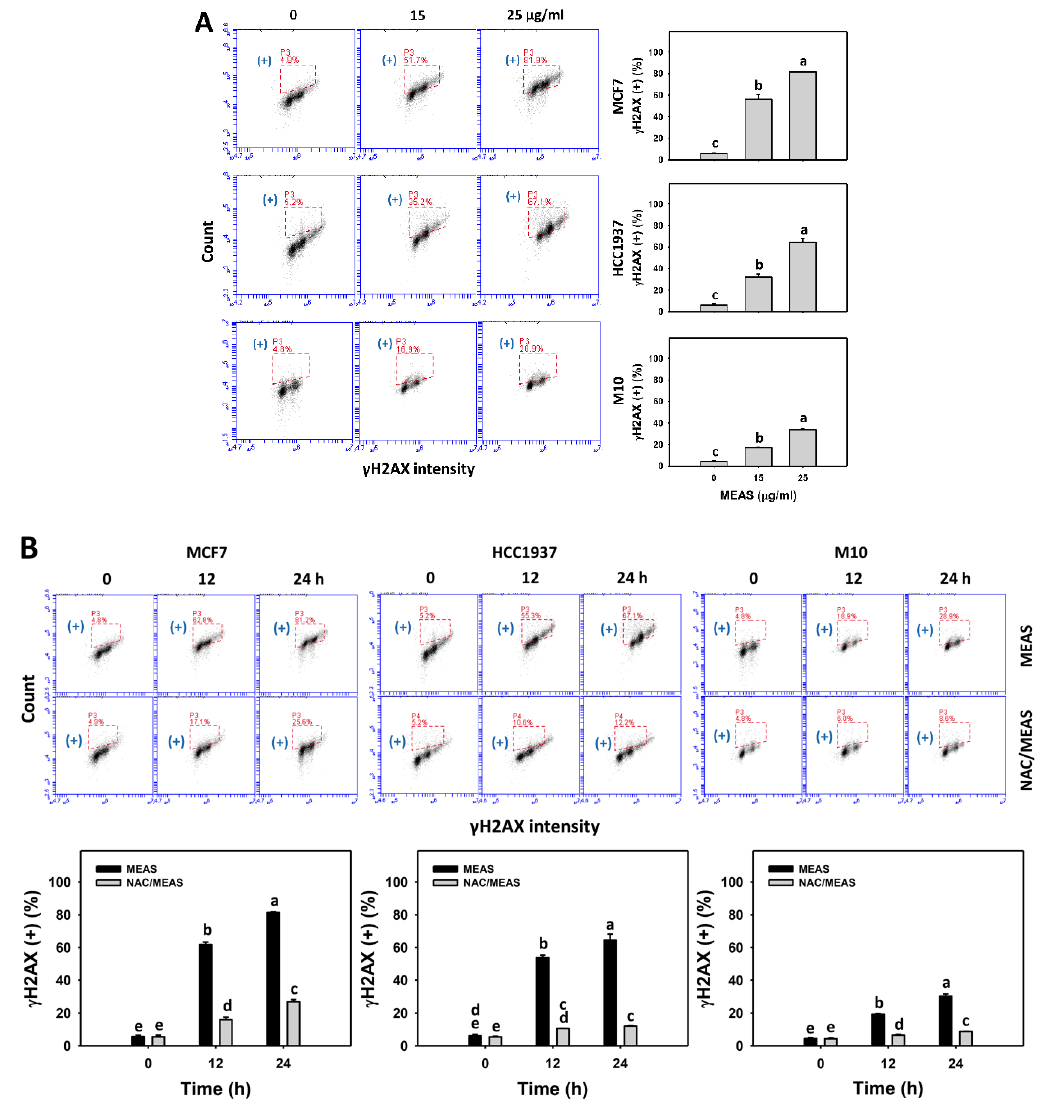
Figure 9. MEAS increased γ H2AX intensity of breast cancer cells. ( A ) γ H2AX assay of MEAS. Except for normal breast cells (M10), others were TNBC and non-TNBC cells. Flow cytometry was performed after 24 h drug treatment. (+), inserted within each panel, indicates the γ H2AX (+) intensity. ( B ) γ H2AX assay of NAC/MEAS. NAC/MEAS represents NAC pretreatment (10 mM, 1 h) and MEAS posttreatment for 0, 12, and 24 h. Data = mean ± SD ( n = 3). Statistical software assigned low-case letters to each